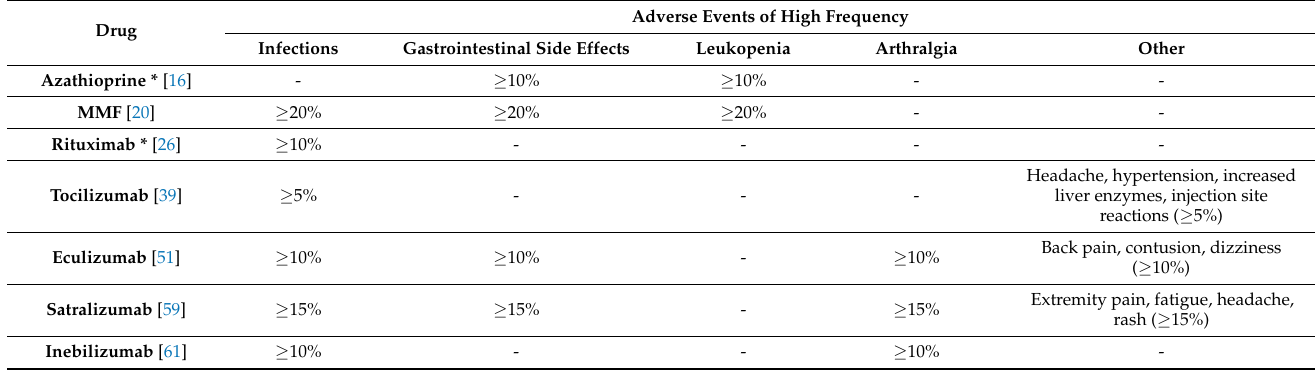
Table 1. Adverse events of high frequency according to the FDA- and EMA-approved prescrib- ing information leaflets. Taking into consideration a dissimilar use of the label “high frequency”, percentages are specified, respectively. * Data from patients with rheumatoid